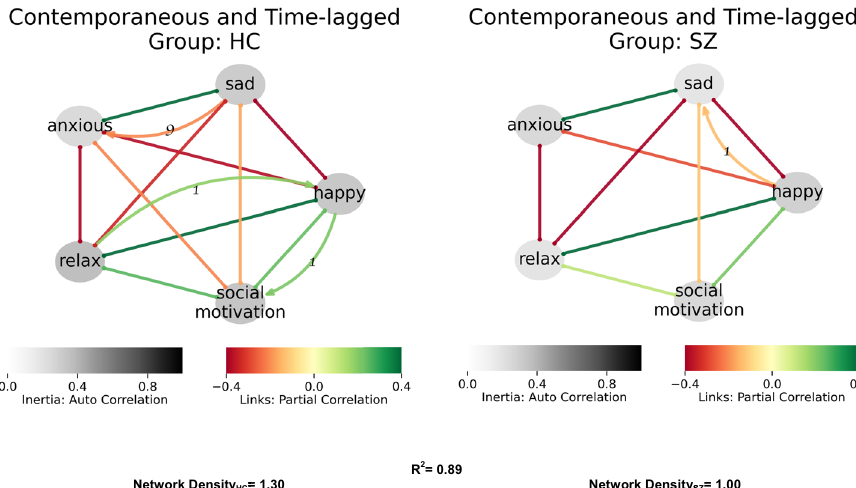
Fig. 1 Affect and motivation. HC network is denser, showing greater connectivity between positive affect and motivation. Happy, relax, and social motivation shows the likely adaptive feedback loop that sustains motivation. The red line represents negative associations while the green lines represent positive associations. Color-depth of links represents the strength of associations (deeper means stronger). Curved lines represent lagged associations and non-curved